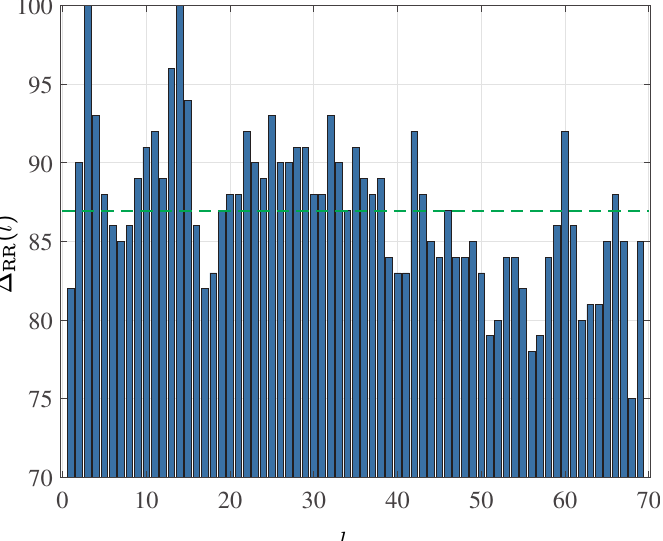
Figure 3. The inter-R-peak distances of one ECG segment of 6000 points. The mean value (green-line) is approximately 87